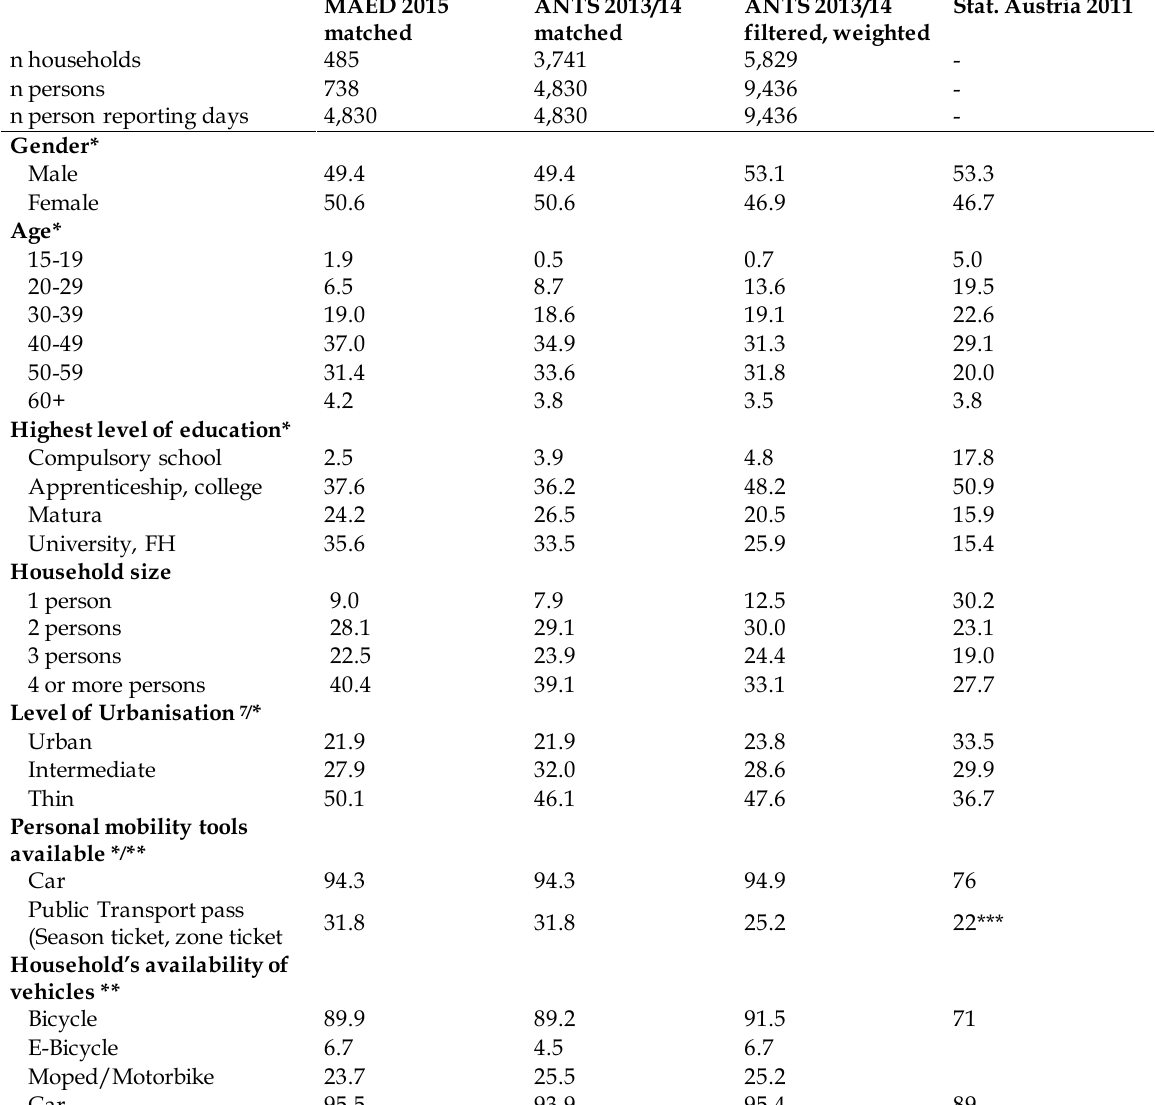
Table 1. Sample characteristics of matched MAED and ANTS data, filtered ANTS data and Austrian National